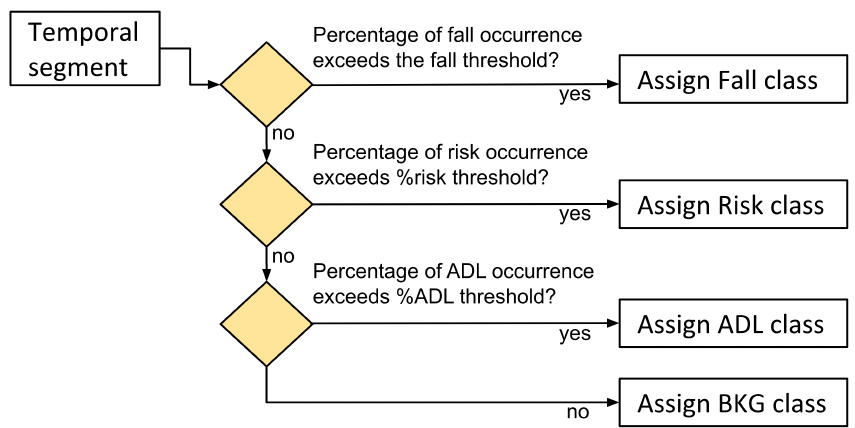
Figure 5. Labelling criteria based on occurrence percentage in each